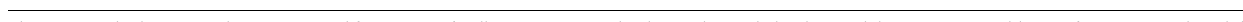
Fig. 3 AIM1 depletion results in increased formation of cell protrusions and enhanced cytoskeletal remodeling. a Western blot con fi rming AIM1 knockdown in sh-AIM1 cells. Numbers below blots show normalized AIM1 intensities ( ± SD) from three independent experiments. b Electron microscopic ultrastructural analyses reveal increased cell size and formation of broad cell protrusions at the leading edge in RWPE-1 cells depleted of AIM1. Scale bar indicates 2 μ m. c Immuno fl uorescence microscopy using probes speci fi c to F-actin (AlexaFluor-labeled phalloidin, red ) and G-actin (monoclonal G-actin- speci fi c antibody, green 21 ) in AIM1 pro fi cient and de fi cient RWPE-1 cells further corroborate the increased size and cell protrusion formation phenotype in sh-AIM1 cells and demonstrate an increased accumulation of G-actin in the trailing edge of sh-AIM1 cells ( arrowheads indicate broad cell protrusions at the leading edge, arrows indicate trailing edge). Scale bar indicates 10 μ m. d Biochemical fractionation of G-actin and F-actin by differential centrifugation reveals increased abundance of G-actin in sh-AIM1 cells. PEL pellet after ultracentrifugation (containing F-actin pool), SUP supernatant after ultracentrifugation (containing G-actin pool), TCL total cell lysate. Left panel shows densitometric quanti fi cation of three independent biochemical fractionation experiments, representing the mean ± SD. e Representative bead trajectory plots for sh-control and sh-AIM1 cells selected from three independent experiments. f Mean-squared displacements (MSD) of nanoscale bead motion analysis in RWPE-1 sh-AIM1 and sh-control cells